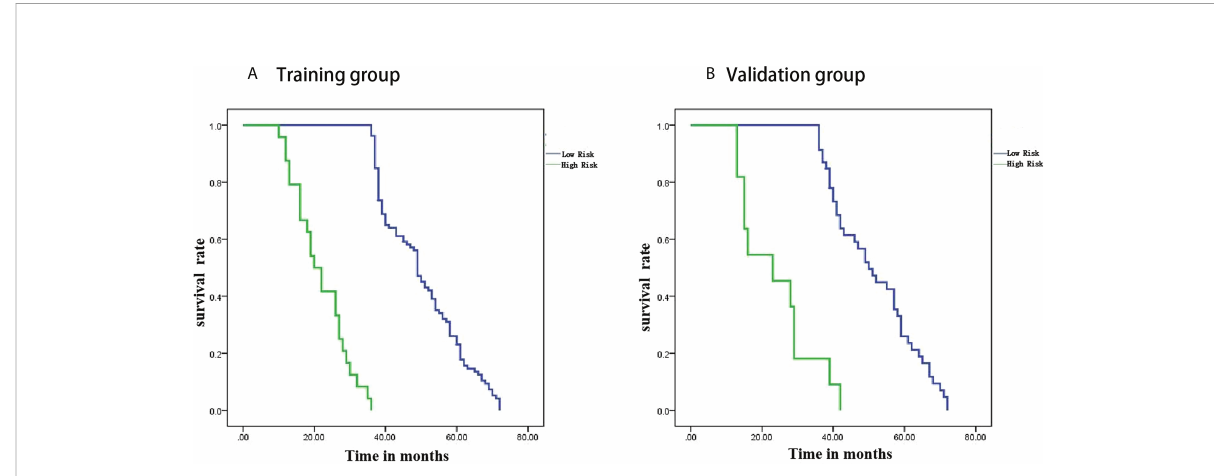
FIGURE 6 Kaplan-Meier analysis. (A) is the training group and (B) is the validation group.